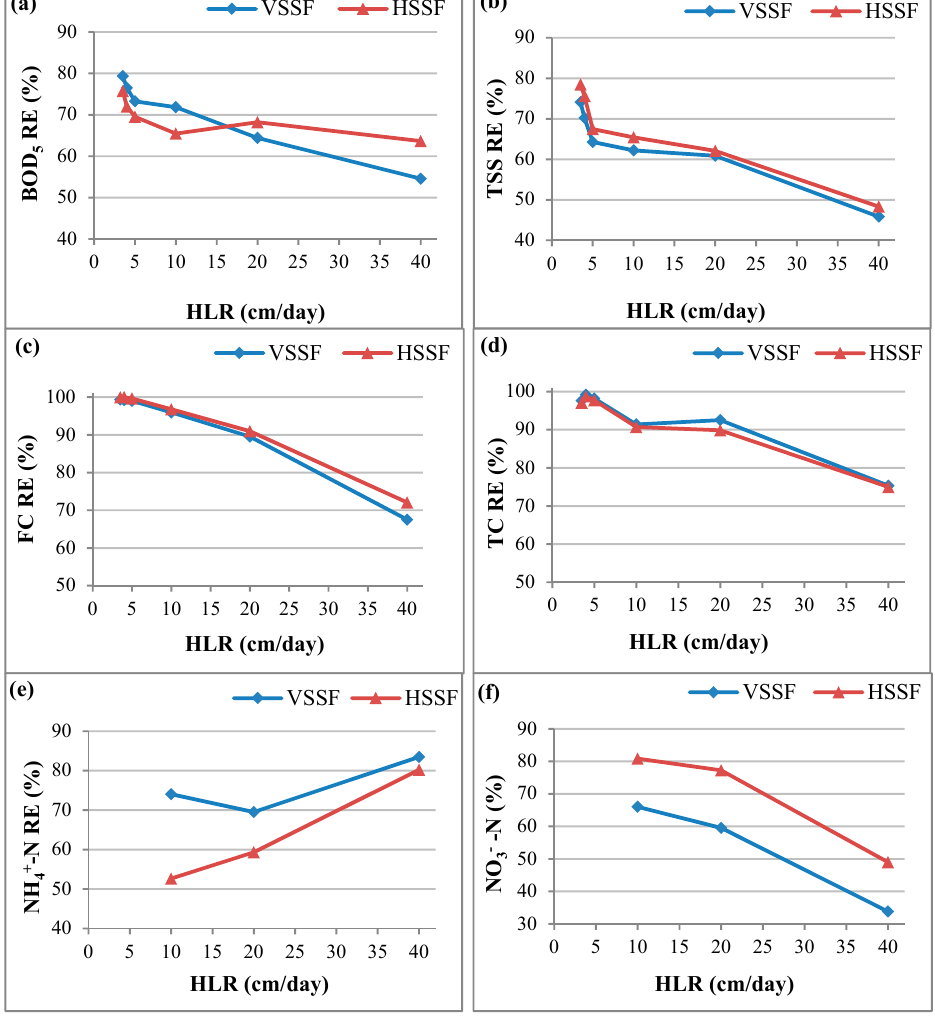
Figure 7. Variation of removal efficiencies (RE) of ( a ) BOD 5 , ( b ) TSS, ( c ) FC, ( d ) TC, ( e ) NH 4+ -N, and ( f ) NO 3 − -N in VSSF and HSSF wetland units versus HLR.